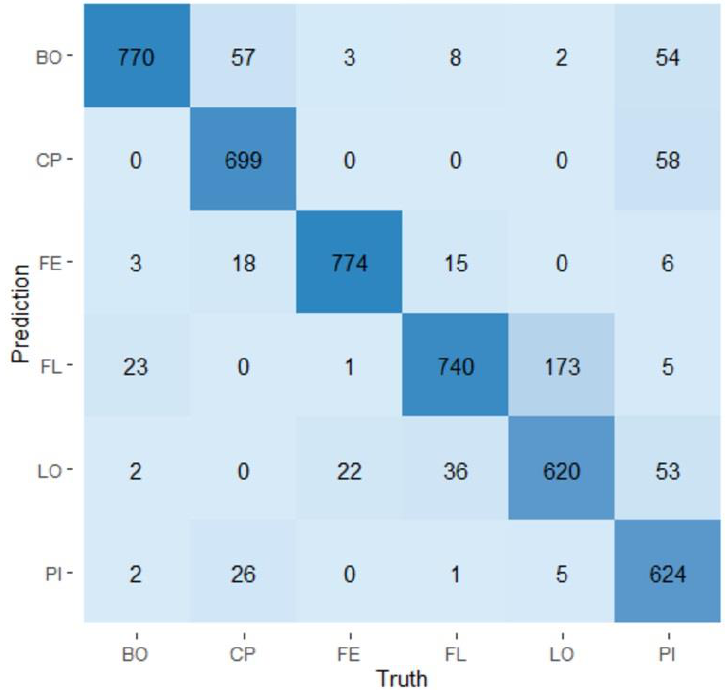
Figure 6. Confusion matrix of the production line model. The x -axis line indicates the identity of the six production lines and the y -axis line shows the prediction of a sample production line based on its microbiota. BO: Boston production line; CP: main production line; FE: Ham production line; FL: Belly production line; LO: Loin production line; PI: Picnic production line.